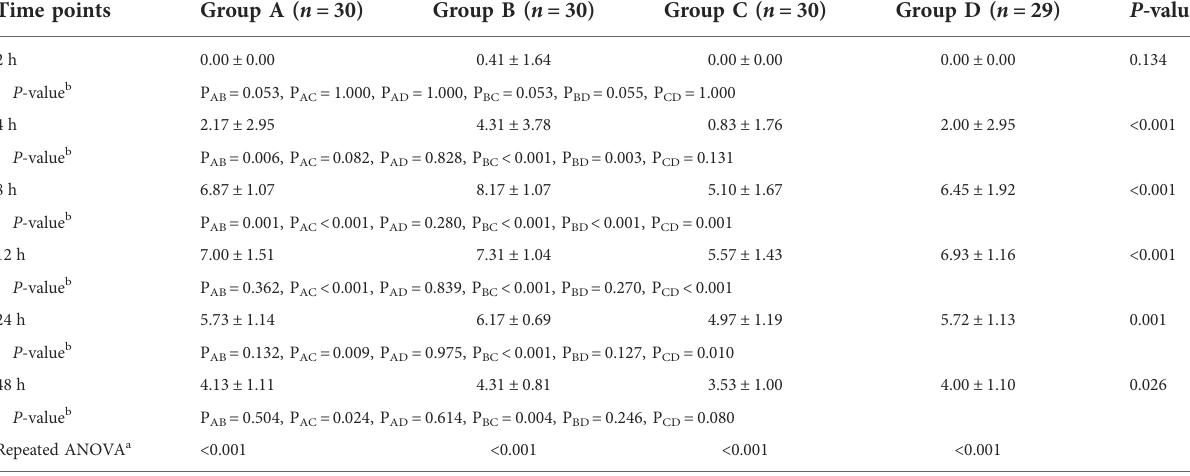
TABLE 3 Postoperative pain score with movement in study groups.